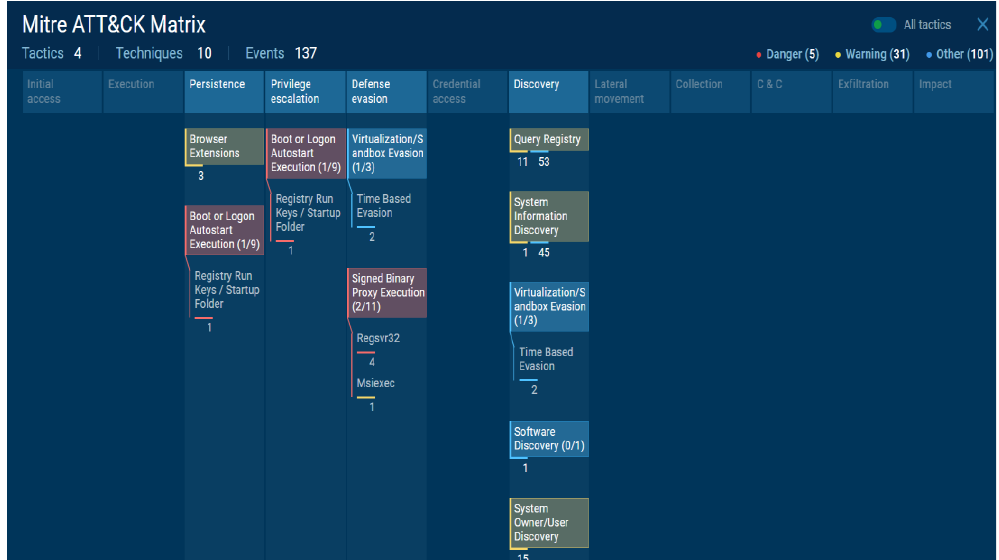
Figure 15. Implementation of MITRE ATT&CK framework visualization of malicious file dynamic analysis results (2).